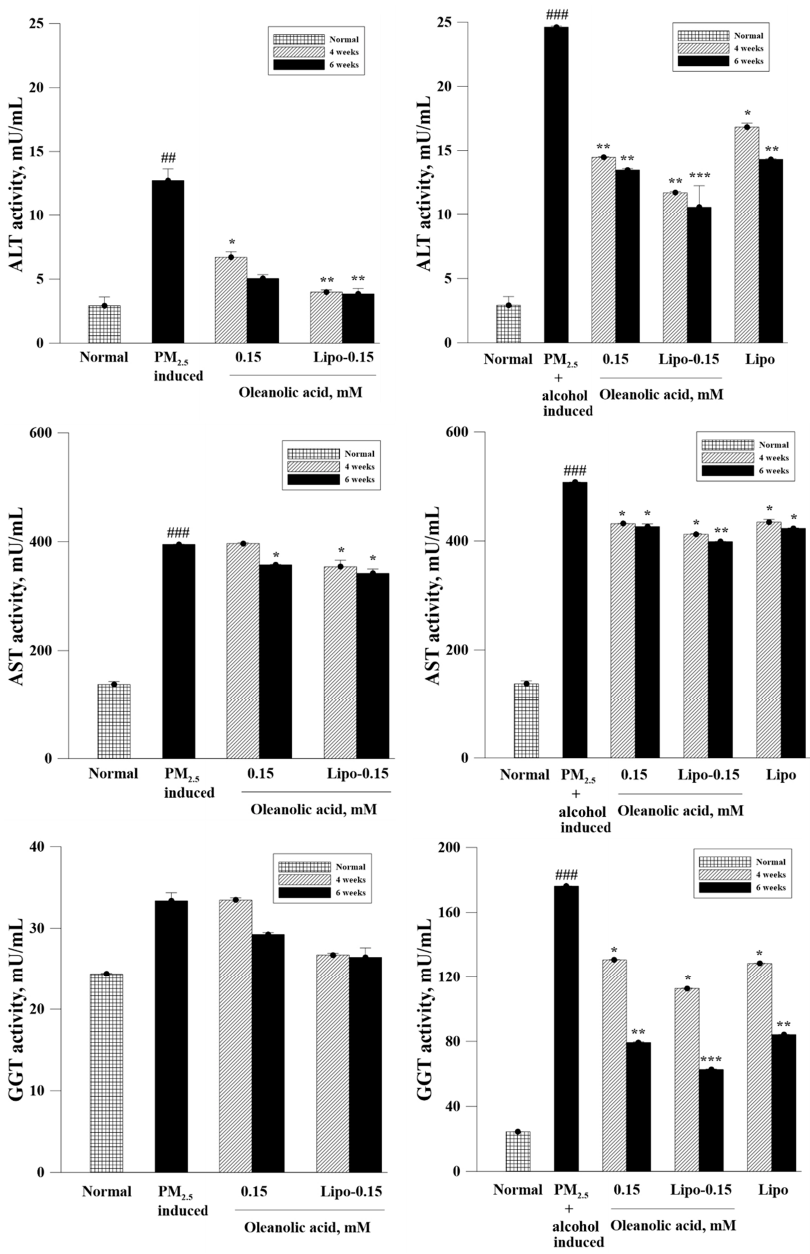
Figure 8. Effects of OA and Lipo ‐ OAs on ALT, AST, and GGT levels in the mice with PM 2.5 or PM 2.5 ‐ and alcohol ‐ induced inflammation in the liver. * p < 0.05, ** p < 0.01, *** p < 0.001 compared with induced group; ## p < 0.01, ### p < 0.001 compared with normal group.